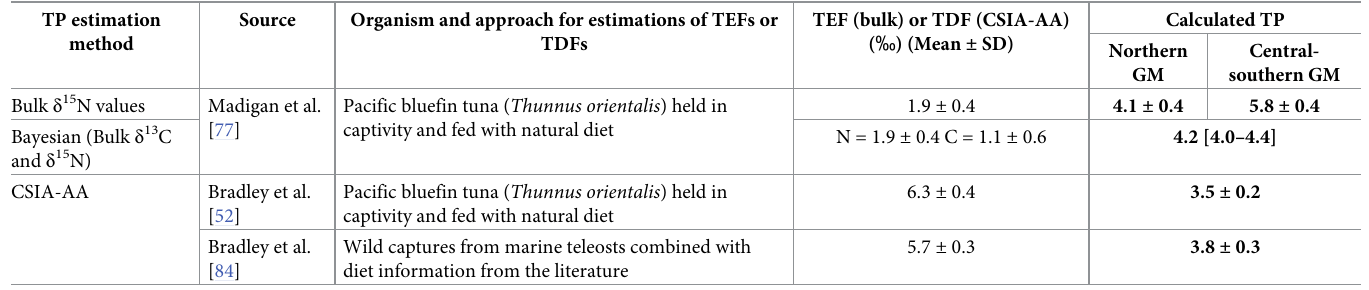
Table 2. Mean trophic position (TP) estimates for yellowfin tuna caught in the central and southern Gulf of Mexico (GM) based on muscle